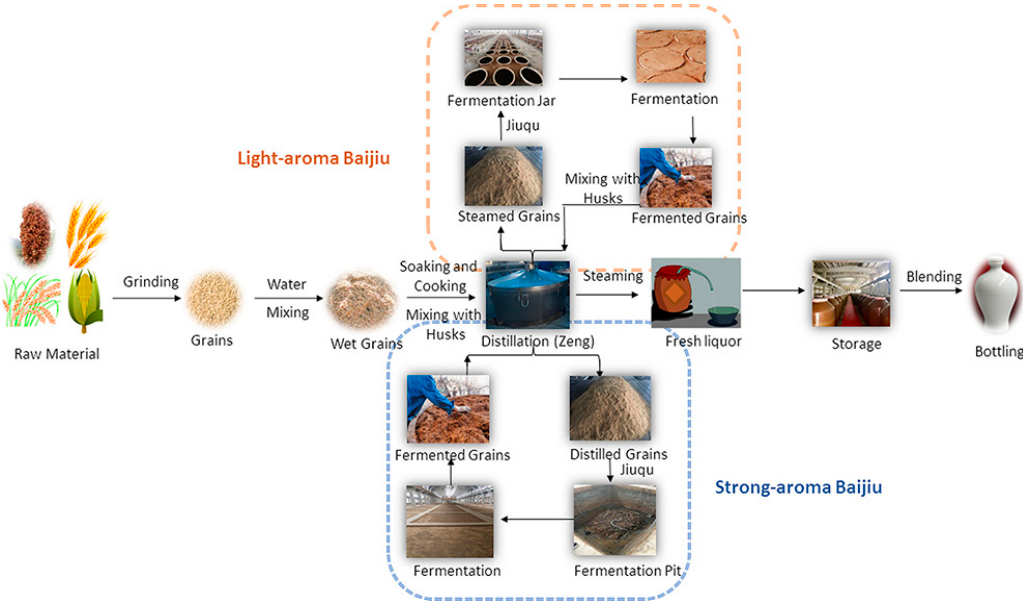
Figure 1. Traditional production processing of Baijiu (Image reprinted from ref. [3], Copyright (2018), with permission from ACS). American Chemical